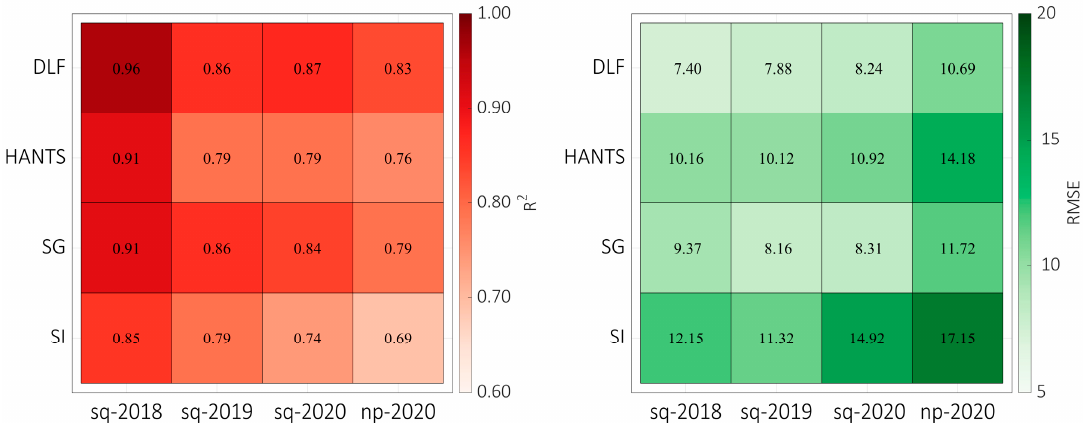
Figure 6. Comparison of extracted and observed phenology from ground observation using different filtering methods. Note: sq and np in the figures each represent the results for the sites in Shangqiu (sq) and Nanpi (np), respectively.